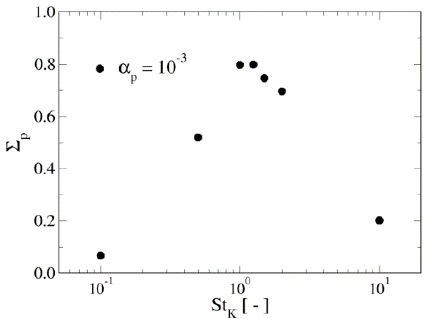
Figure 3. Particle segregation parameter, Σ p , variation versus particle Stokes number. Σ p presents a peak for the maximum attained clustering, reached for St K ∼ 1. Data are for volume fraction α p = 0.1%.